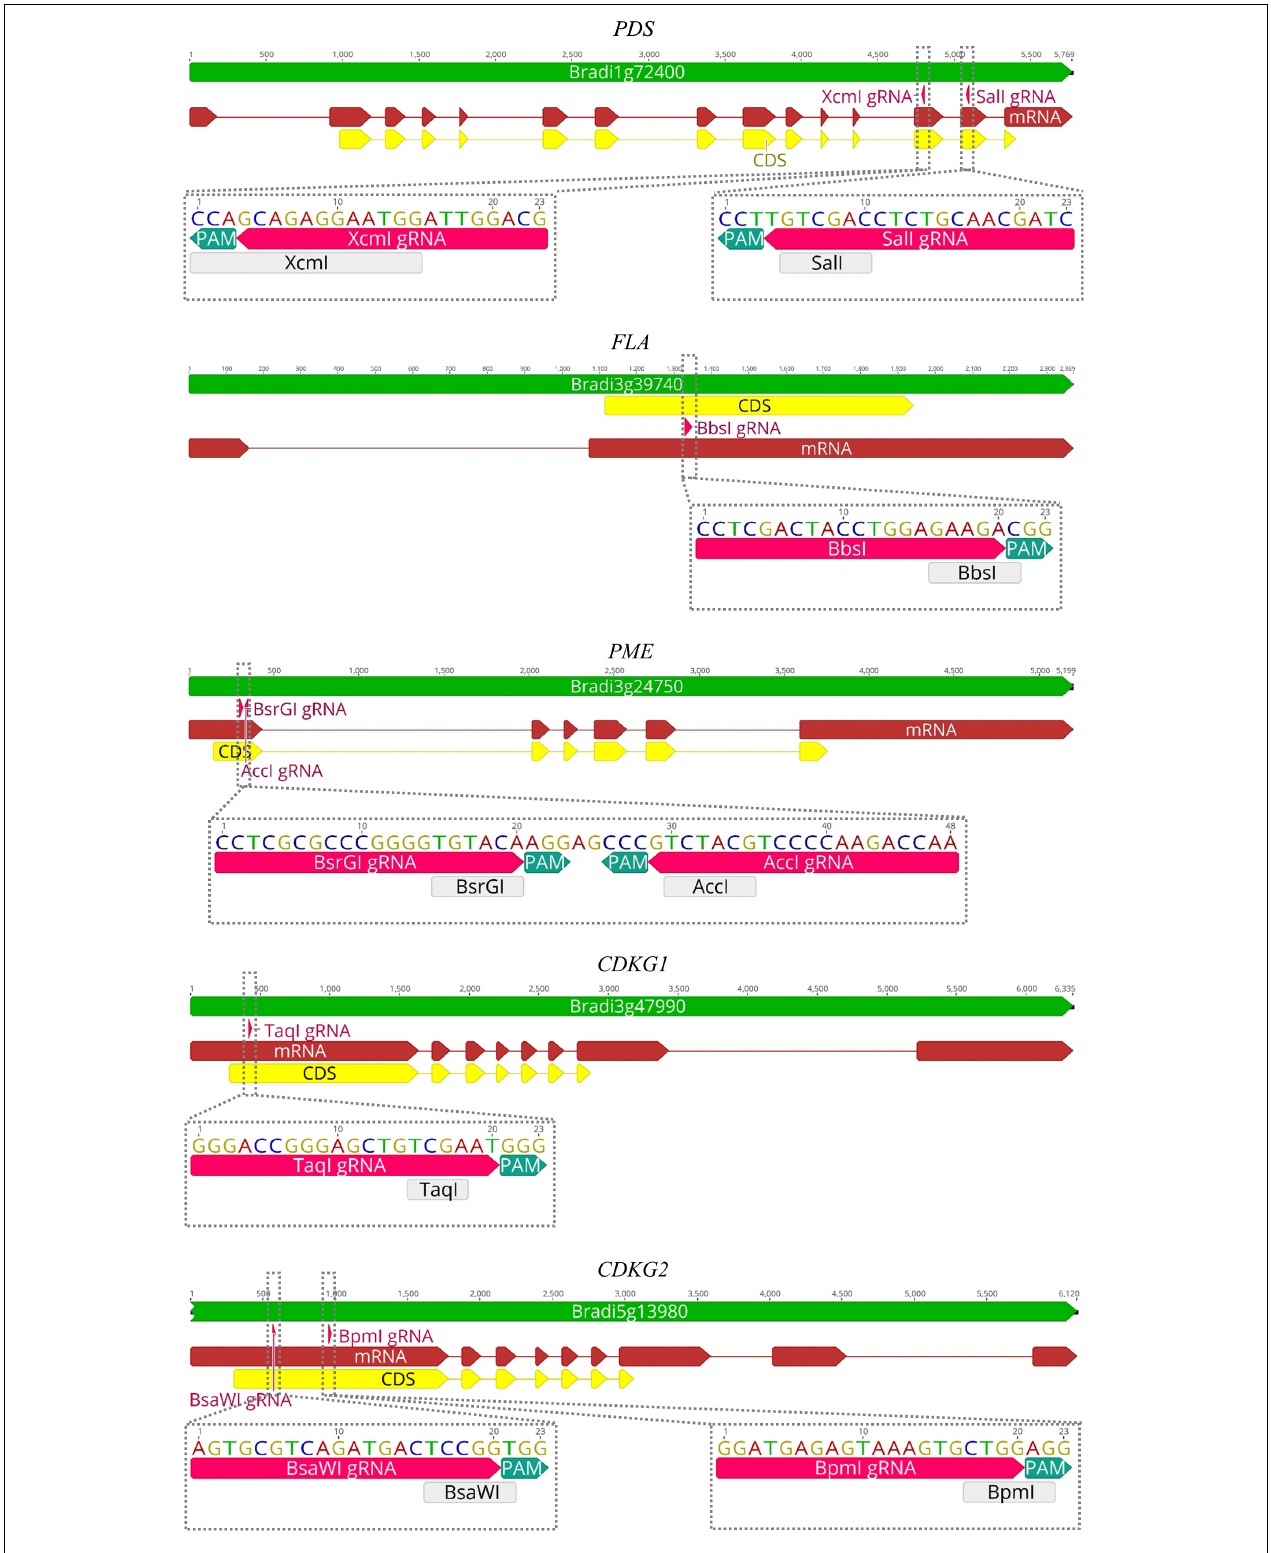
FIGURE 4 | Maps of PDS , FLA , PME , CDKG1, and CDKG2 genes with marked positions of gRNAs (pink arrows) and appropriate restriction sites (light gray rectangles). PAM – protospacer-adjacent motif.